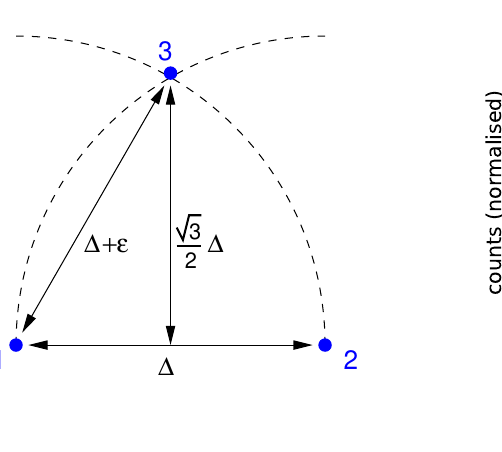
of each declustering and t √ = 1 / 3 < 1 , t /k t, critical